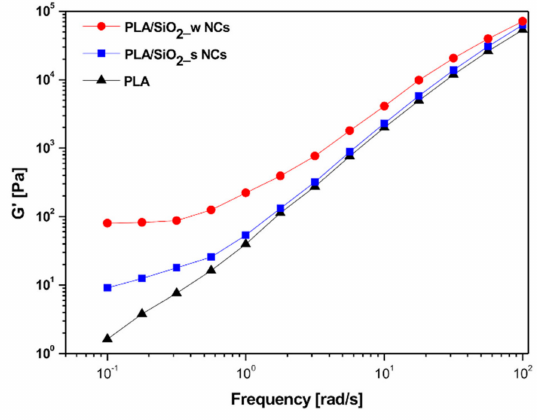
Figure 8. Storage modulus G’ of pure PLA and PLA / SiO 2_ s and PLA / SiO 2_ w nanocomposites.